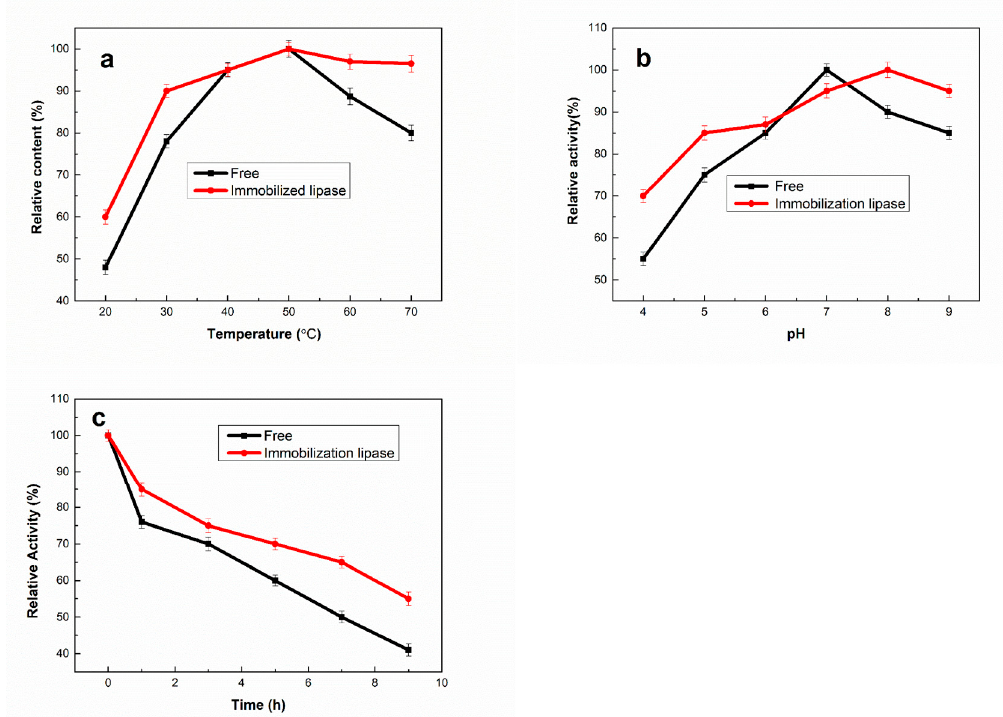
Figure 6. Effects on the stability of immobilized and free enzymes. ( a ) temperature, incubated at pH 7.5 for 15 min; ( b ) pH, incubated at 40 °C for 15 min; and ( c ) time, incubated at pH 7.5 and 60 °C.